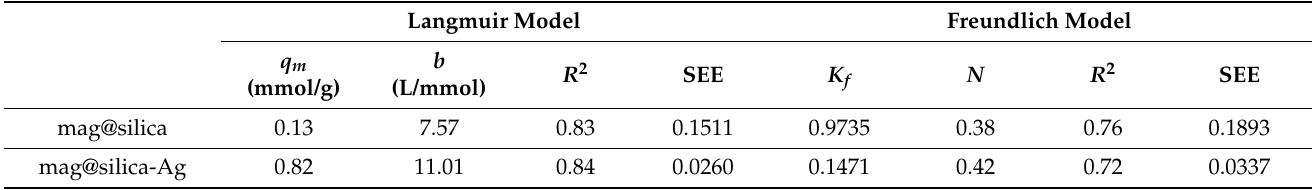
Table 4. Langmuir and Freundlich isotherm parameters for the adsorption of I − onto mag@silica and mag@silica-Ag. Langmuir